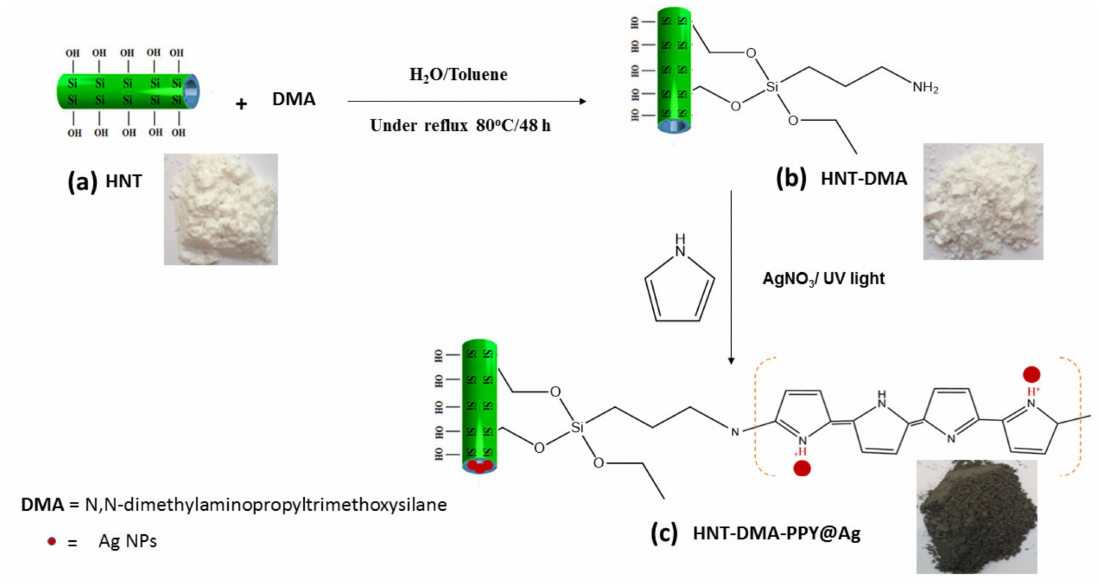
Figure 2. Sequential modification steps of halloysite nanoclay (HNT) by dimethylaminopropyltrimethoxysilane (DMA) coupling agent, followed by in-situ photopolymerization of Py. The digital photographs show HNT ( a ), silanized halloysite ( b ), and HNT-DMA-PPy@Ag ( c